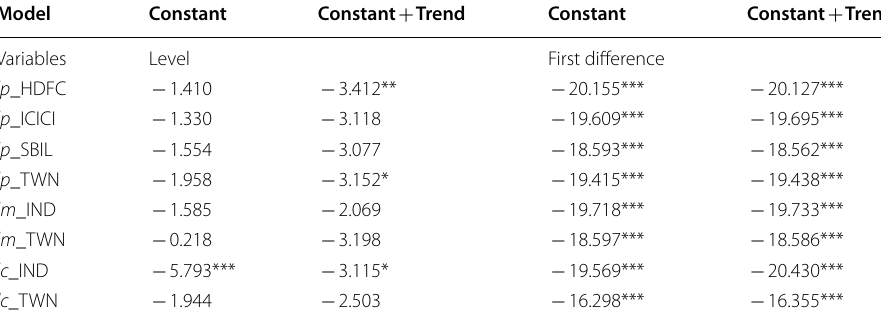
Table 2 Phillips Perron unit root